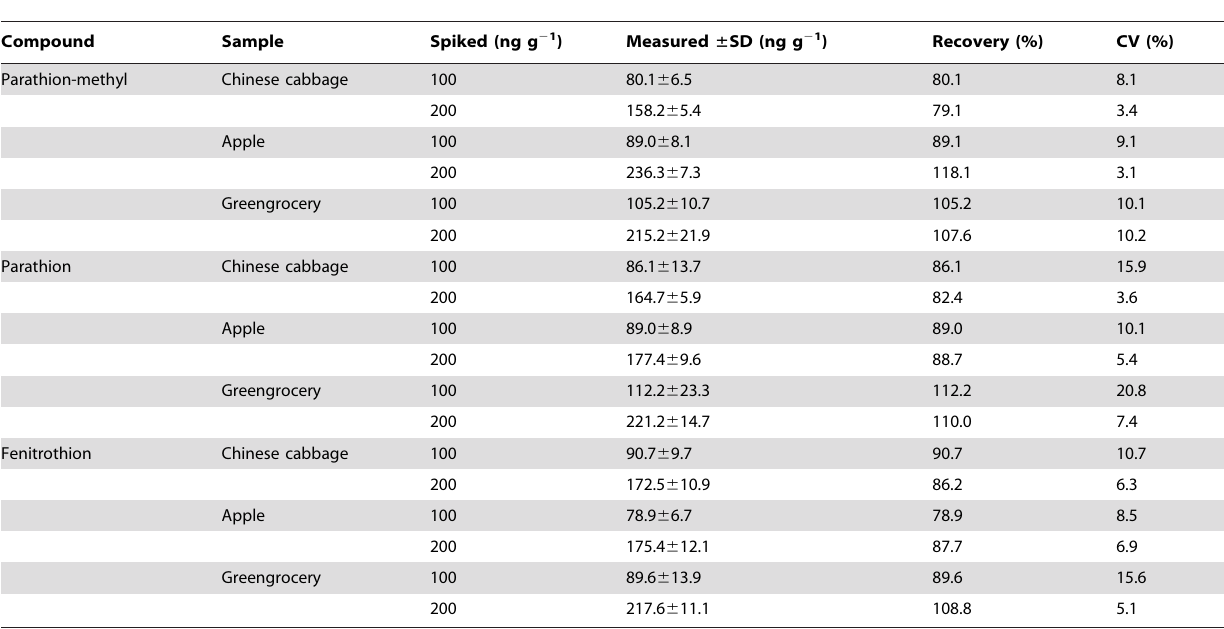
Table 4. Recovery studies of samples spiked with parathion-methyl, parathion, and fenitrothion by multi-analyte ELISA ( n =3).